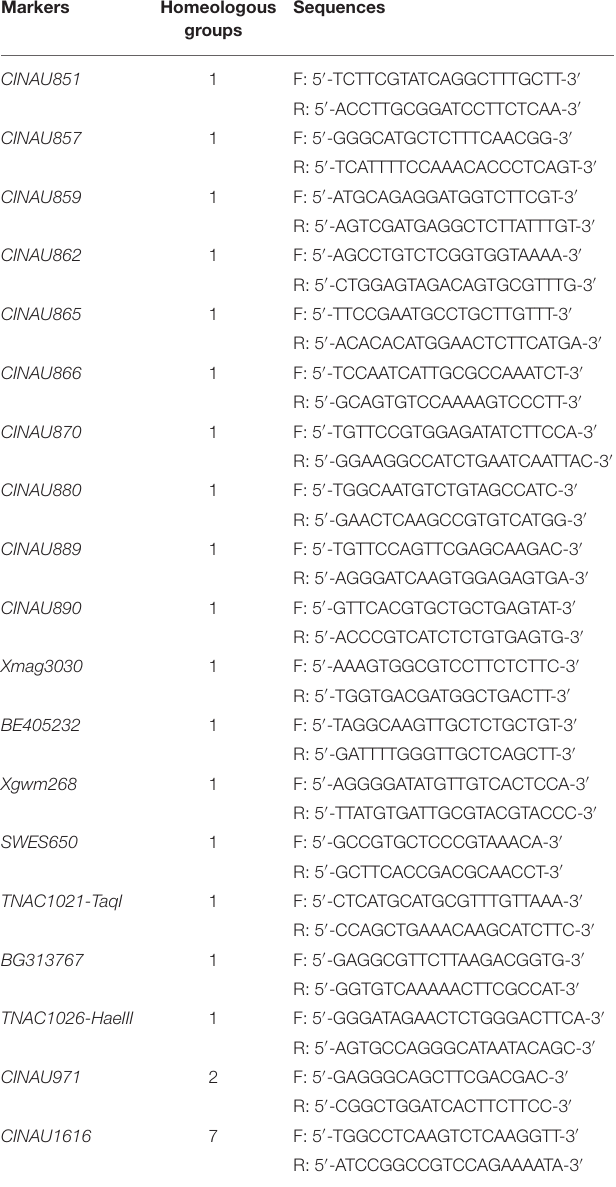
TABLE 3 | Markers specific to the alien chromosomes of SN19647.